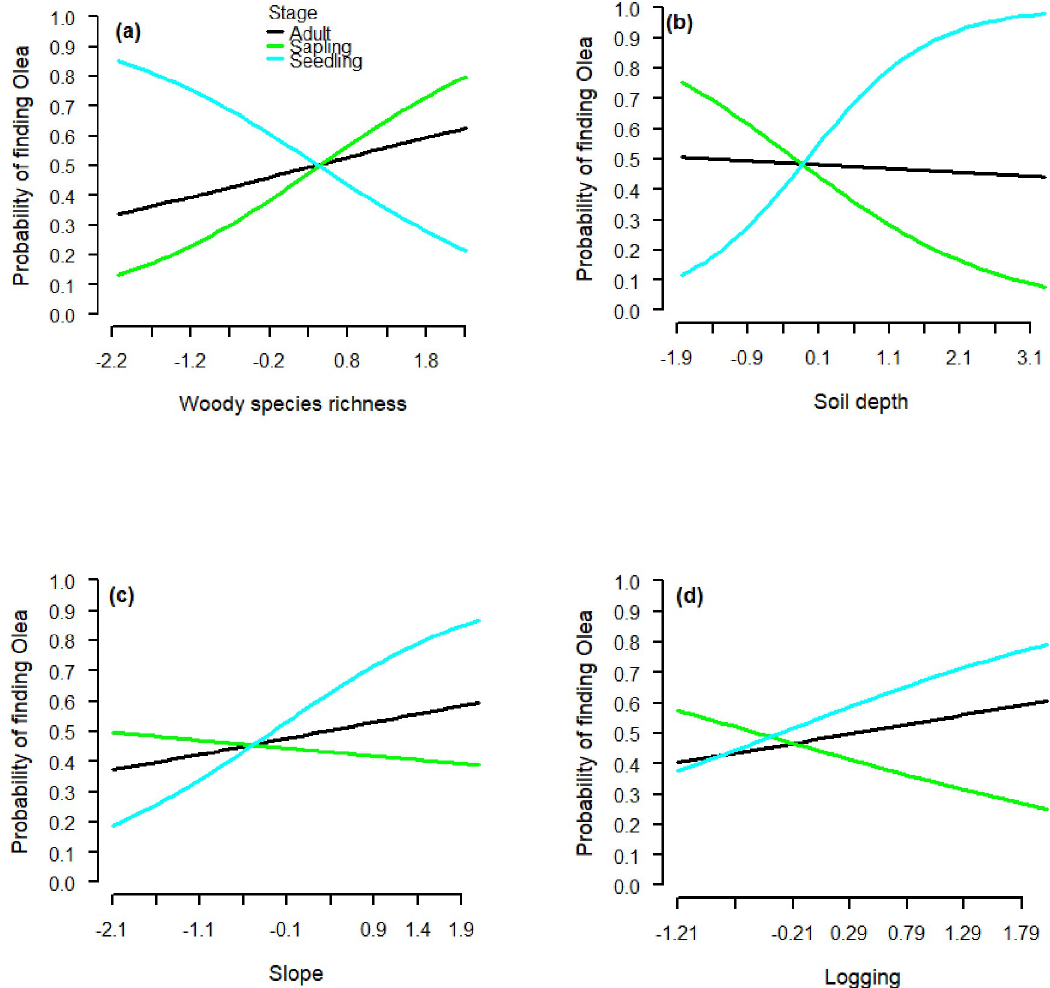
Fig 4. Estimated relationships between the probability of finding O . europaea and woody species richness, soil depth, slope and logging, for different ontogenetic stages (adult, sapling, seedling; see Table 2) in Hugumburda dry Afromontane forest in northern Ethiopia. Note that the explanatory variables were standardized before analysis and plotting. Observed values ranged from 6 to 24 species for woody species richness, from 0.01 to 1.20 meters for soil depth, from 0.03 to 0.94 degrees for slopes, and logging intensity from 0 to 13 for number of stumps per 20 × 20 m observation plots for